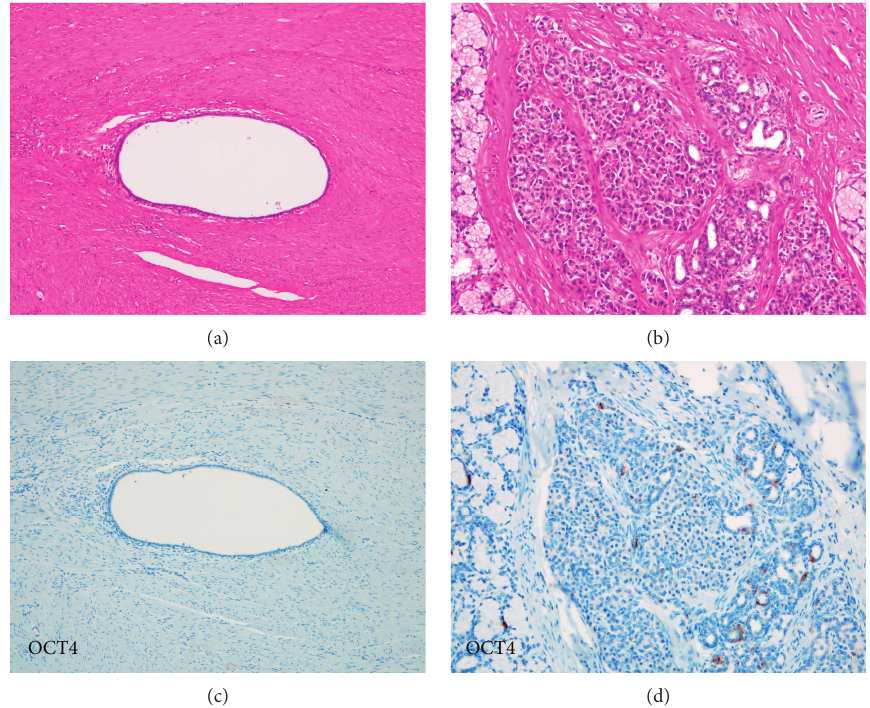
Figure 4: Histological findings. OCT 4 is not identified in the cells of the dilated glands ((a): HE staining; (b) OCT4). A small population of small gland cells was positive for OCT4 ((c): HE staining; (d):